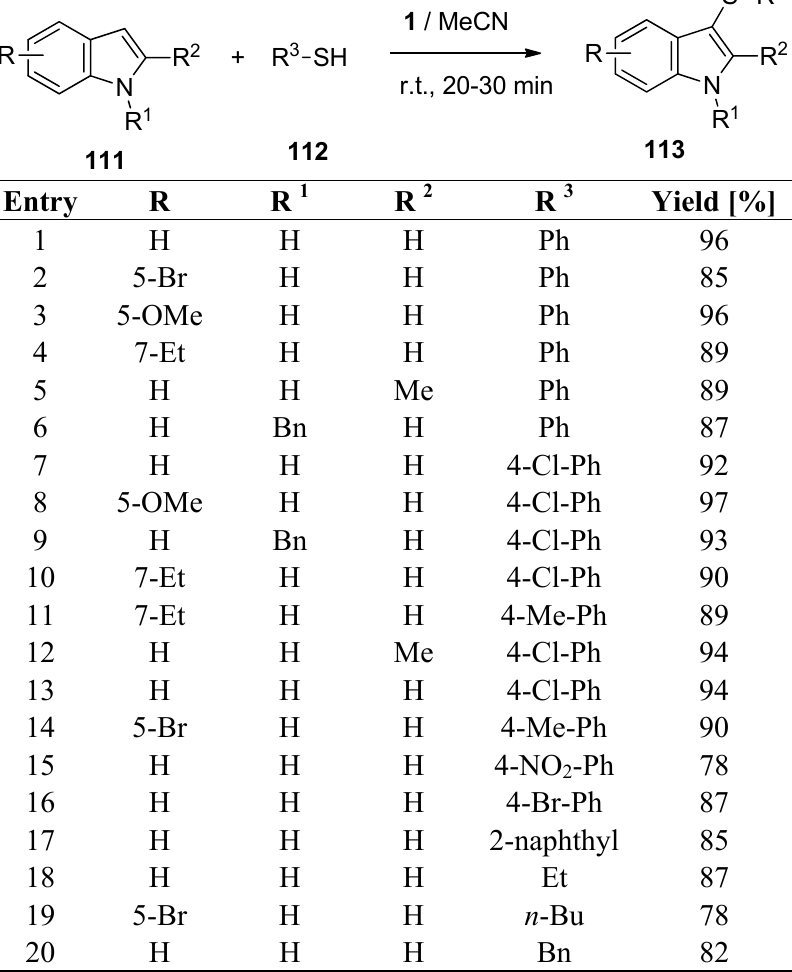
Table 8. F-TEDA-BF